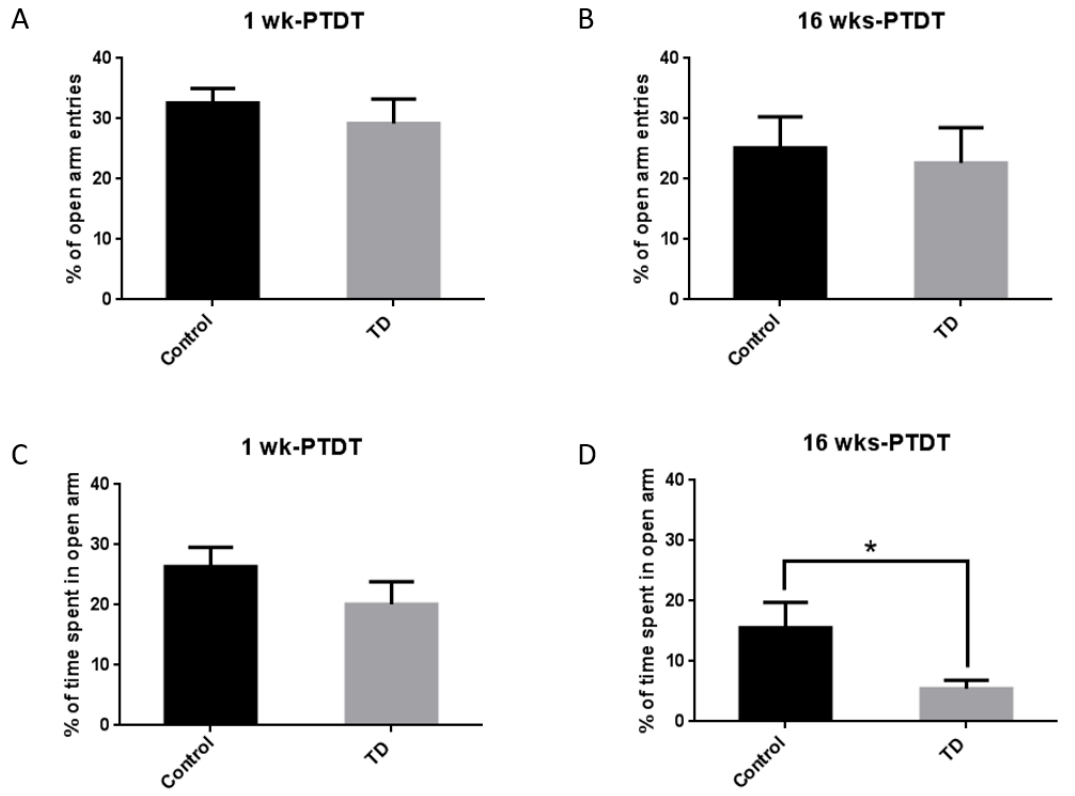
Figure 4. The results of the elevated plus maze (EPM) test of the two cohorts after TD treatment. The percentage of open-arm entries was calculated for the 1 wk-PTDT cohort ( A ) and the 16 wks-PTDT cohort ( B ). The percentage of time spent in open arms was determined for the 1 wk-PTDT cohort ( C ) and the 16 wks-PTDT cohort ( D ). For the 1 wk-PTDT cohort, n = 10 for both control and TD groups. For the 16 wks-PTDT cohort, n = 10 for the control group, and n = 9 for the TD group. * p < 0.05 denotes a statistically significant difference from the control group.